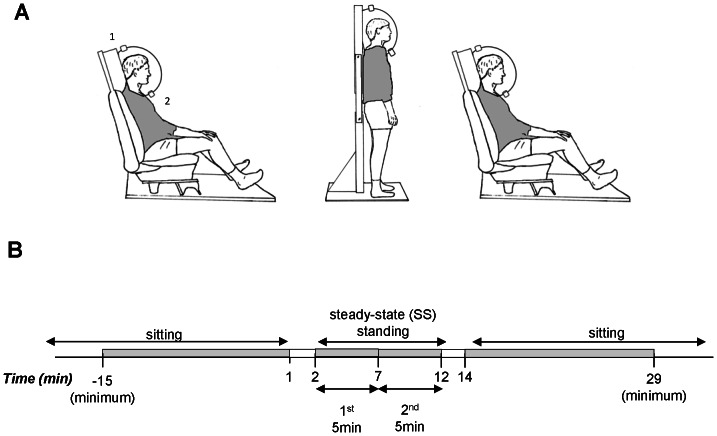
Experimental design and time-line.Schema of experimental design. Posture-adapted ventilated hood indirect calorimetry set-up for sitting and standing measurements (Panel A). The shaded area shows that the area of the subject covered by the veil of the ventilated hood. 1 = air inlet; 2 = air outlet to Deltatrac. Diagrammatic representation of experimental time-line (Panel B). The shaded areas represent the time periods during which minute-by-minute EE and RQ measurements were recorded. A minimum of 15 min of stable measurements were recorded during each sitting period. During postural transition (from sitting-standing, and standing-sitting) the ventilated hood was removed and no measurements recorded. The 10 min steady-state standing period was further divided into two 5 min blocks for data analysis, referred to as “1st 5 min” (minutes 3 to 7, inclusive) and “2nd 5 min” (minutes 8 to 12, inclusive) of the SS-standing period, respectively.